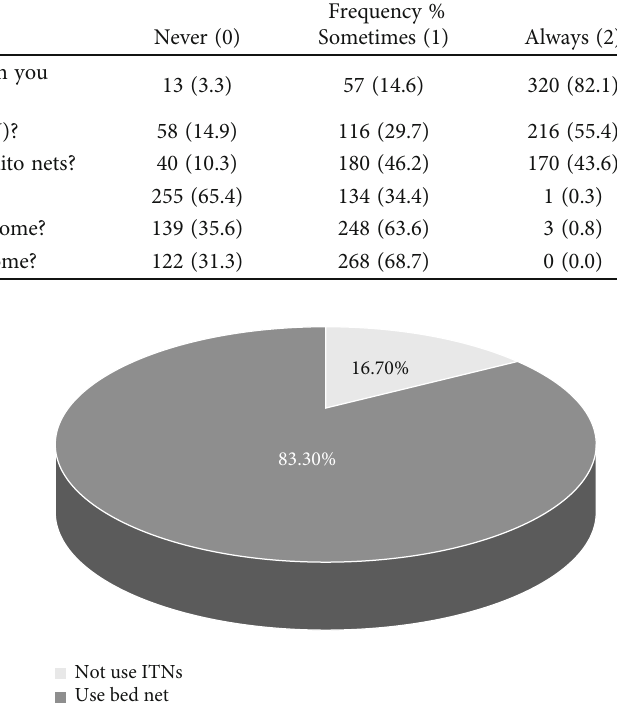
Figure 2: Practice of using ITN among the respondents in Mekaneeyesus hospital,